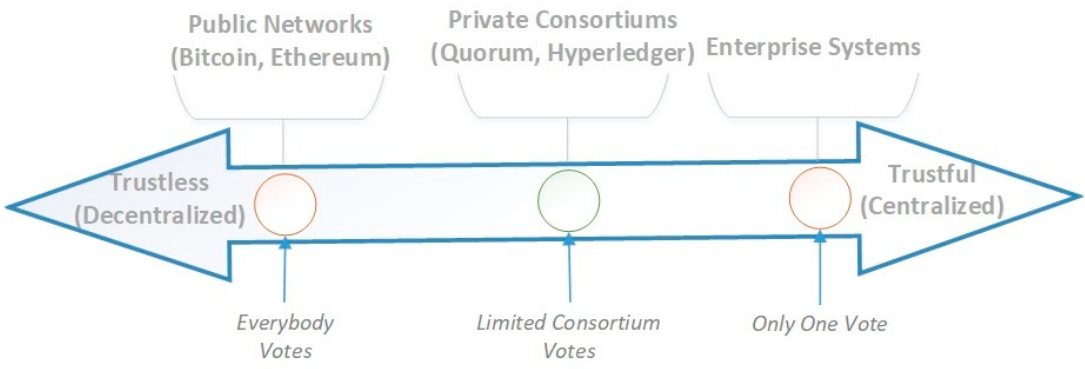
Figure 3. The trust continuum in state-of-the-art networks [25].